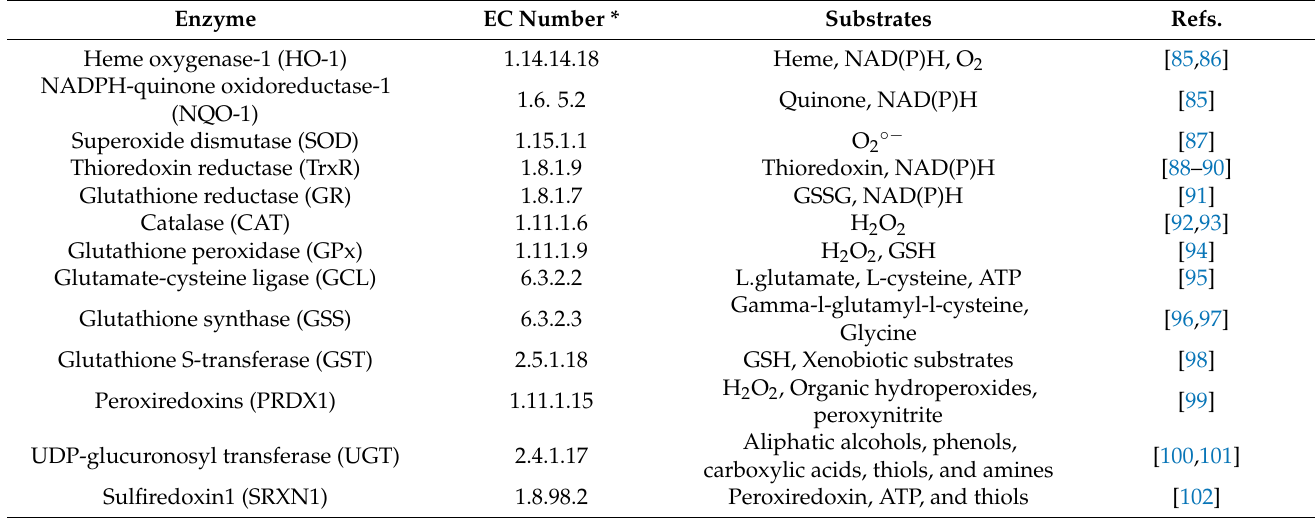
Table 1. Keap1/Nrf2/ARE relevant downstream